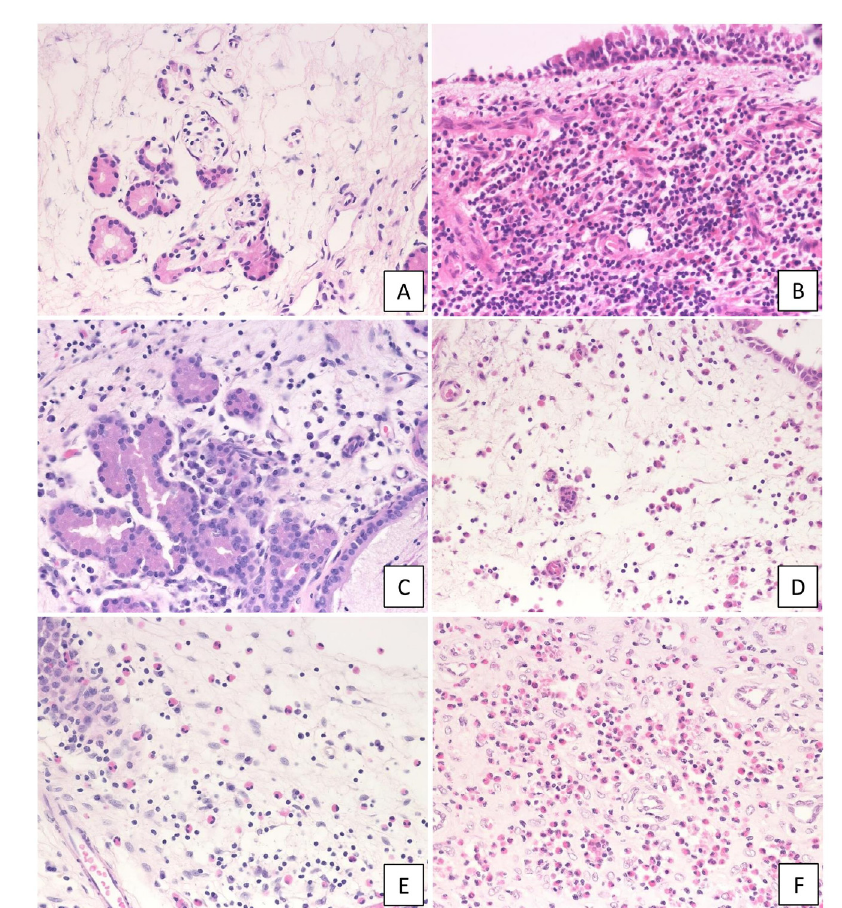
Figure 1. Histological findings of non ‐ chronic rhinosinusitis (CRS), CRS, and eosinophilic chronic rhinosinusitis (ECRS). Hematoxylin and eosin staining at 400 magnification (high ‐ powered field, HPF). ( A ) non-CRS, ( B ) CRS with no visible NP in the middle meatus (CRSsNP), ( C ) non-ECRS, ( D ) mild ECRS, ( E ) moderate ECRS, and (F) severe ECRS. In ECRS, infiltration of eosinophils under the mucosa was observed.